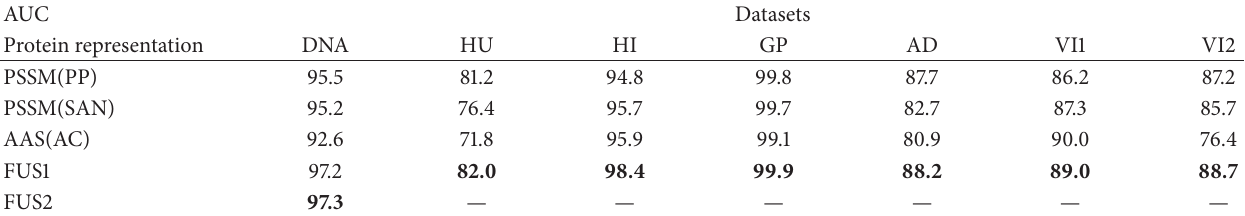
FUS2 Table 8: Comparison among ensembles and best stand-alone descriptors in terms of AUC in multiclass problems. AUC Datasets Protein representation MEM PSSM(PP)